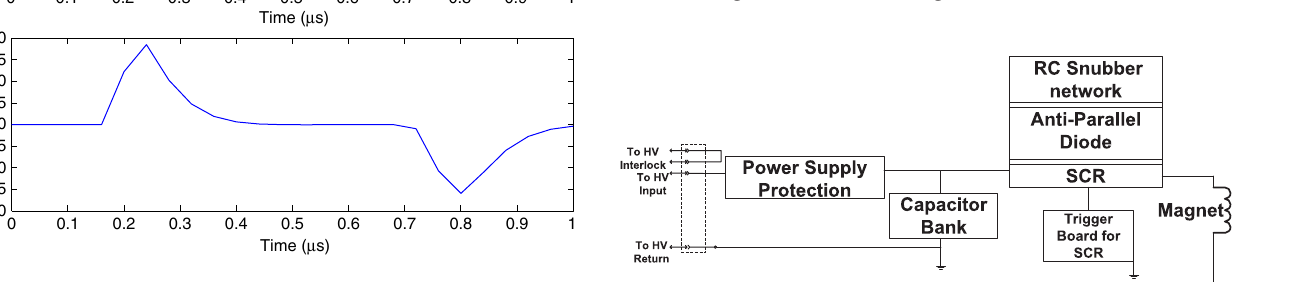
FIG. 10. Booster injection kicker simulated waveform. The upper plot is the current through the kicker, and the lower plot is the voltage across the kicker. FIG. 11. Booster injection septum driver block